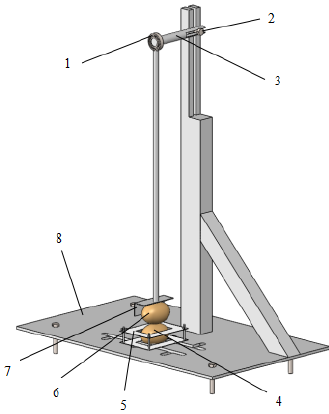
Figure 1. Single pendulum friction test device. 1. Rolling bearing. 2. Adjusting nut. 3. Supporting shaft. 4. Friction material. 5. Fixture 1. 6. Potato. 7. Fixture 2. 8. Test bench support.